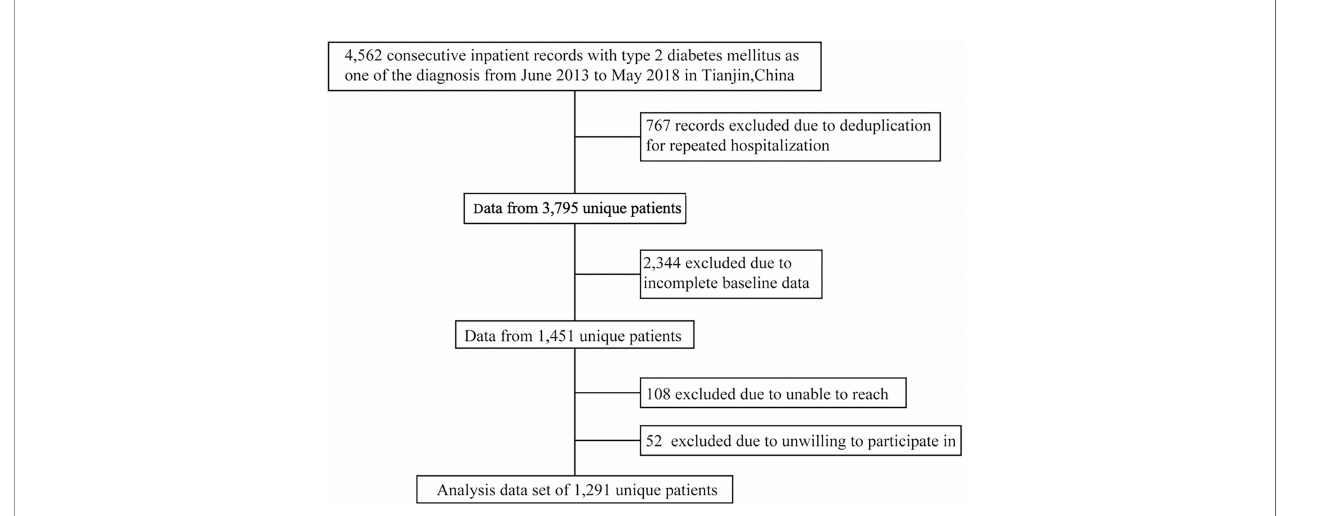
FIGURE 1 | Flow chart of identi fi cation of the study